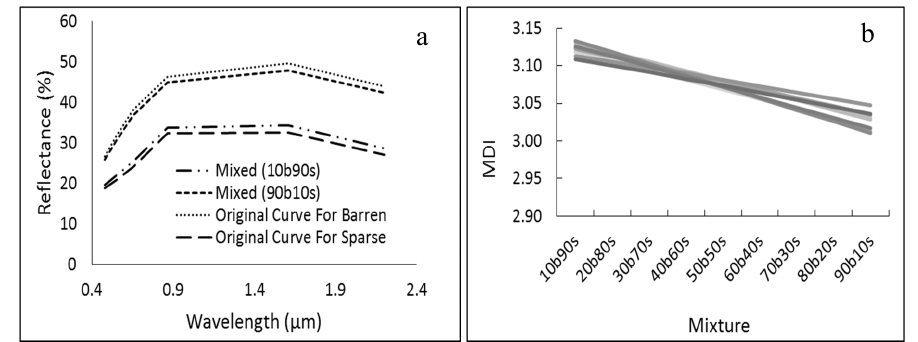
Figure 9. In ( a ), sample spectral curves of the barren land and sparse vegetation classes are shown with the original curve plus the curves with mixed reflectances. In ( b ) are values of the MDI at varying mixture of spectral reflectance. A mix of 90b10s indicates 90% barren land and 10% sparse vegetation, while a mix of 10b90s indicates 10% barren land and 90% sparse